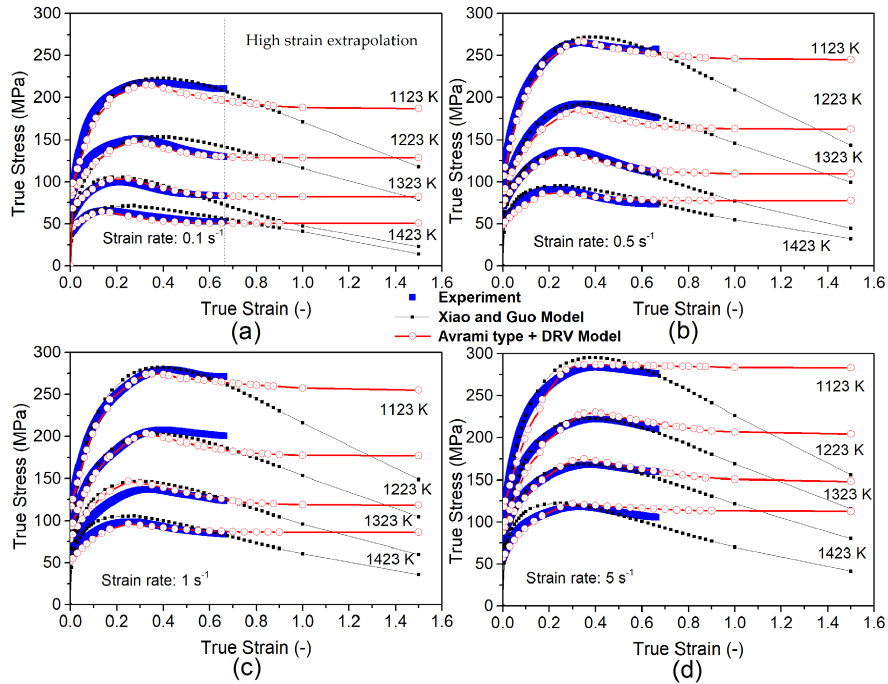
Figure 13. Comparison between experiment flow curves and the two different models with high strain extrapolation for the DIN 18MnCrSiMo6-4 steel for different strain rates and temperatures, (a) Strain rate 0.1s -1 , (b) 0.5s -1 , (c) 1s -1 and (d) 5s -1